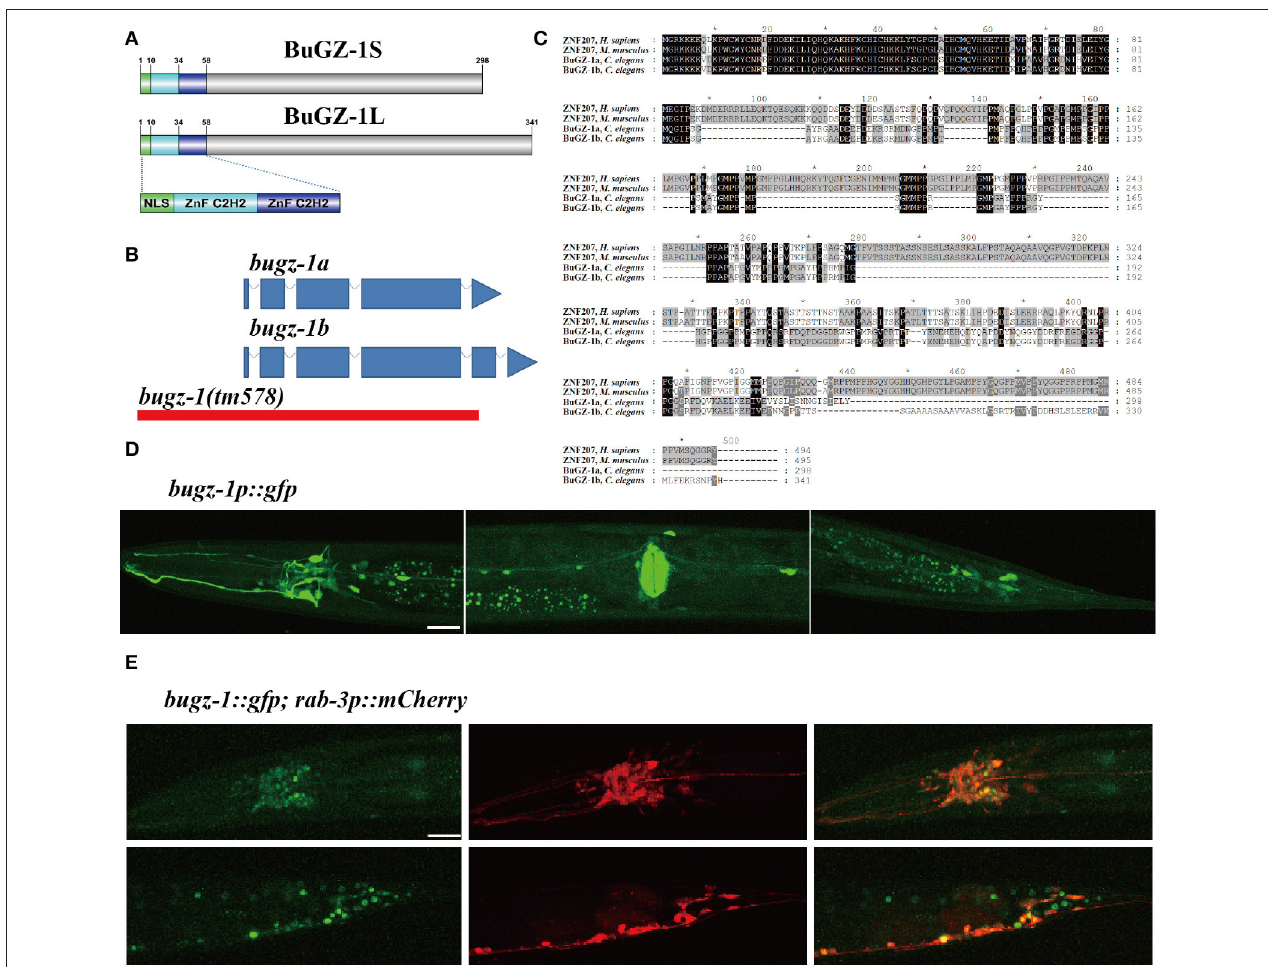
( Figure 3C ). We generated a bugz-1p::gfp construct by driven GFP under the promoter of the bugz-1 gene. GFP signals were observed throughout nervous system and muscles,